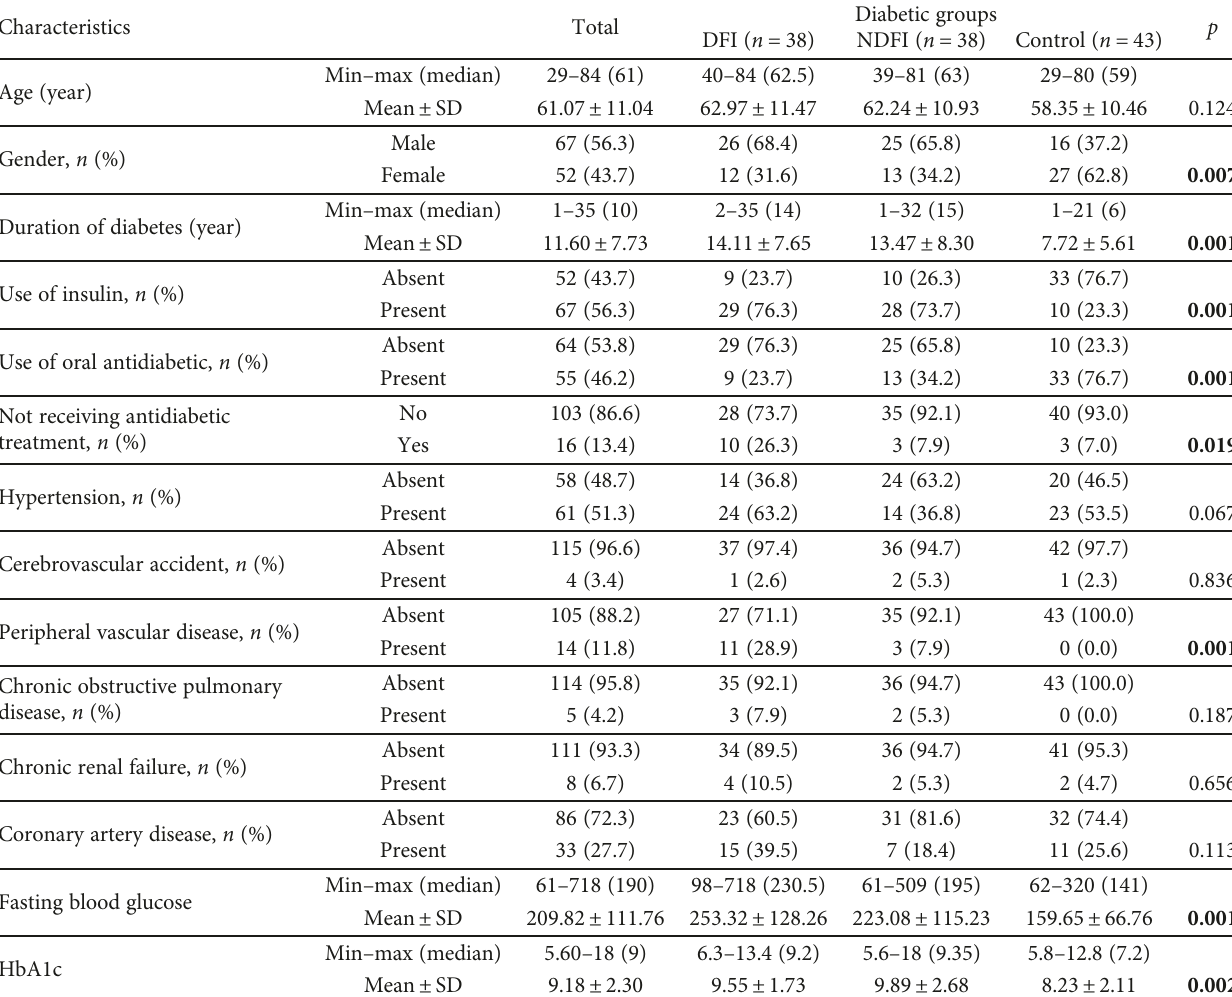
Table 1: Demographic characteristics of the